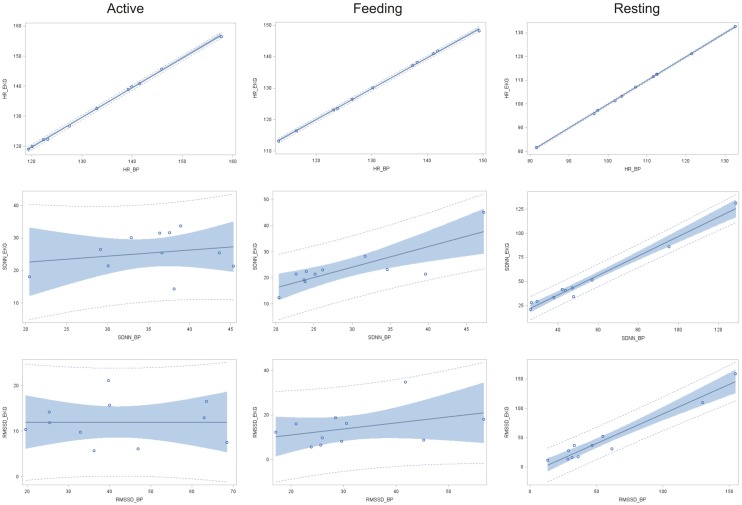
Linear regression of HR, SDNN, and RMSSD obtained via ECG in function of those obtained using BP (n = 11) with according 95% confidence limits (gray area) and 95% prediction limits (dotted line) during active behavior, feeding, and resting.